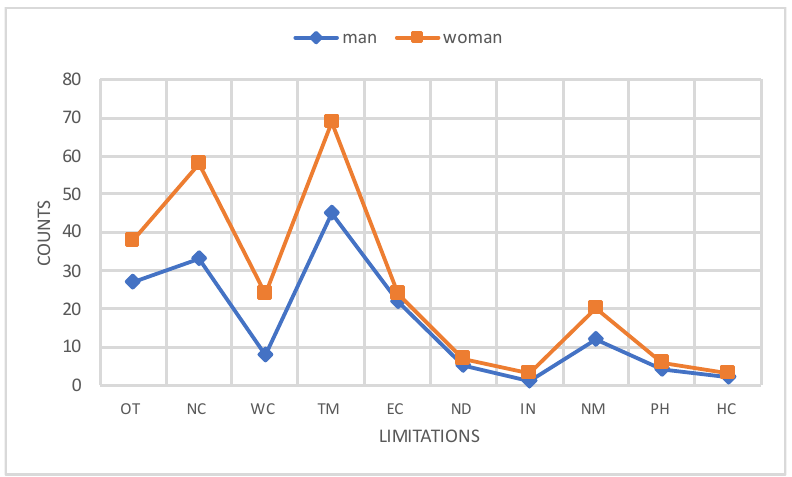
Figure 28. Graph of the interactions between the limitations to bus availability and the gender of the respondent.